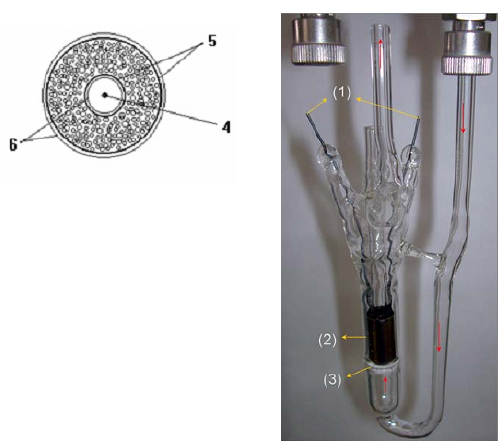
Figure 6. The own-design sensing cell utilized with powder samples, with (1) tungsten wires, (2) coaxial tantalum electrodes (cylinder type), (3) ceramic frit, (4) thermocouple (slice view), (5) coaxial tantalum electrodes (slice view), and (6) glass walls (slice view), from ref. [31].